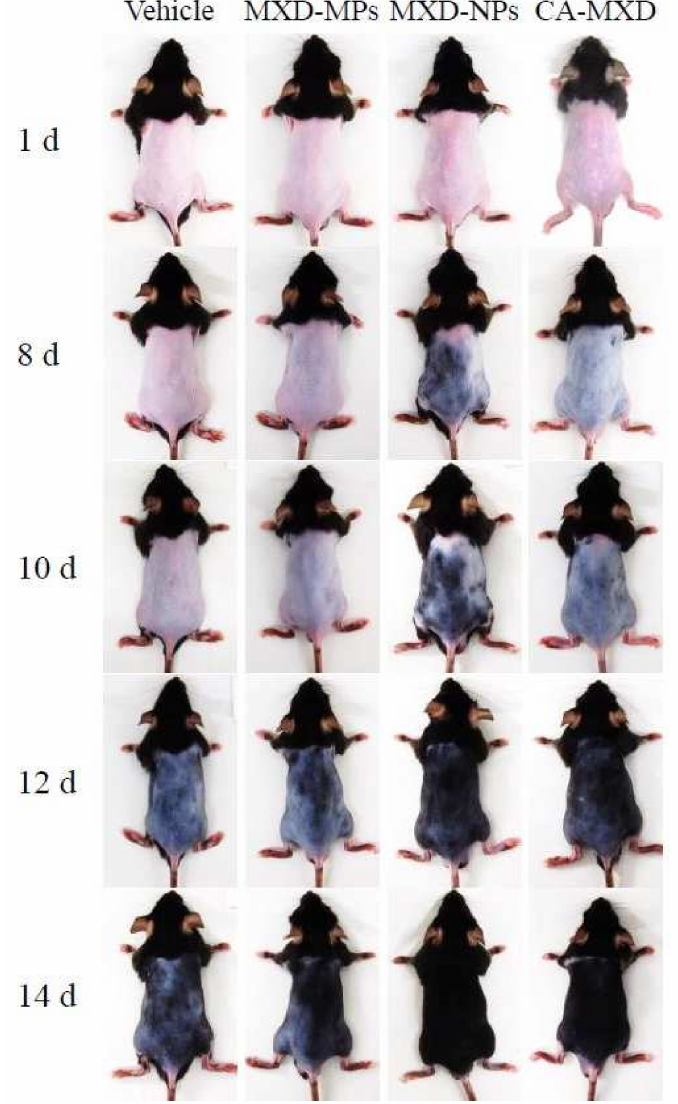
Figure 3. Digital photos of C57BL/6 mice repetitively treated with MXD formulations (once a day). Vehicle, only the vehicle used to prepare the MXD-MPs and MXD-NPs formulations was applied. MXD-MPs, MXD-MPs-applied mice. MXD-NPs, MXD-NPs-applied mice. CA-MXD, CA-MXD- applied mice. The repetitive applications of MXD-NPs enhanced the hair growth, compared with repetitive applications of MXD-MPs or CA-MXD.